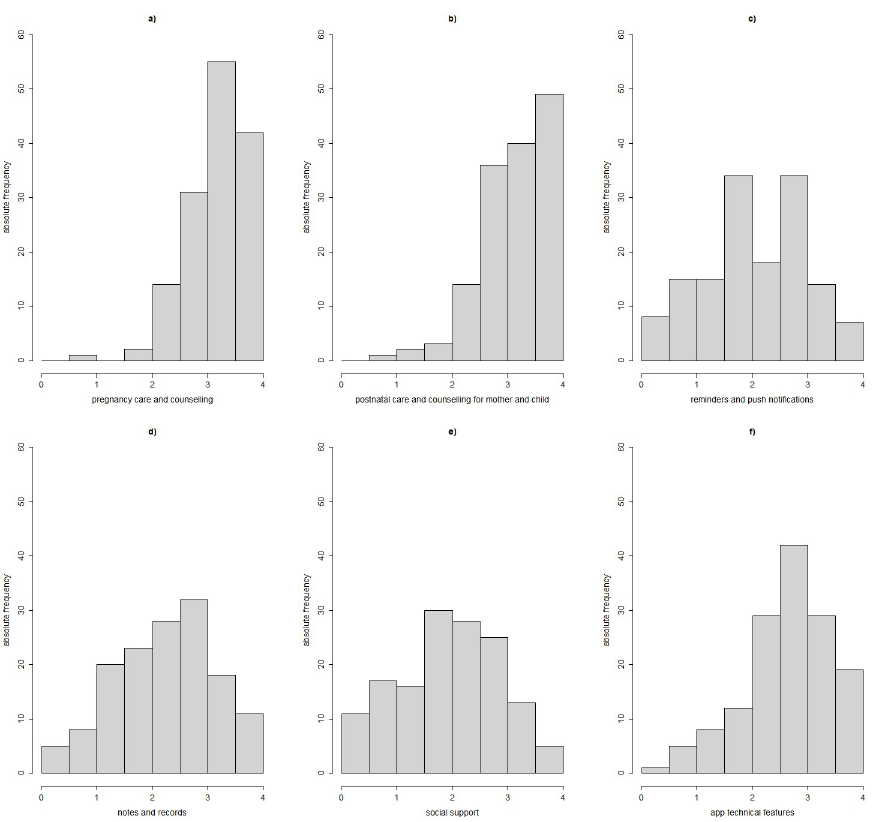
Fig 1. Distribution of health professionals’ opinions on the contents, functionalities, and technical features of an mHealth app to support the first 1000 days of life, grouped by the six questionnaire domains.